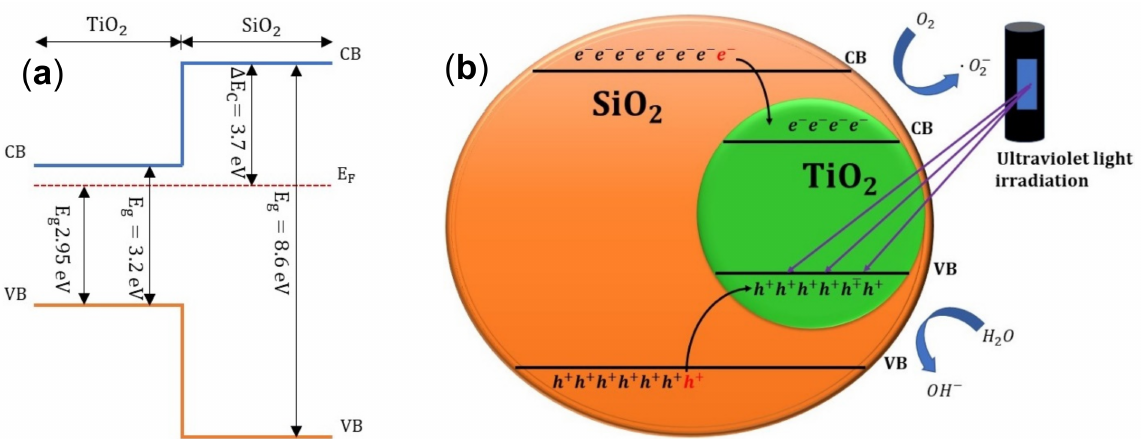
Figure 10. ( a ) TiO 2 -SiO 2 Band diagram. ∆ CB and ∆ VB denote the conduction and valence band offset between SiO 2 and TiO 2 , respectively, and E F denote the Fermi level. ( b ) Photodegradation mechanism of TiO 2 -SiO 2 under UV light